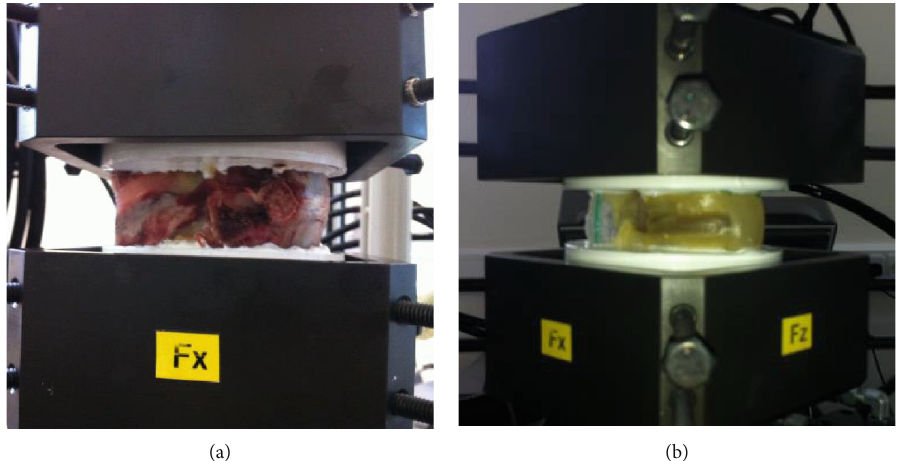
Figure 4: Experimental setup for (a) porcine spine and (b) synthetic paediatric spine in the MTS Bionix Servohydraulic spine simulator.